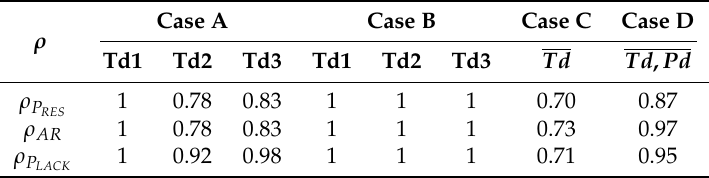
Table 8. Approximation ratio for small-scale scenarios.